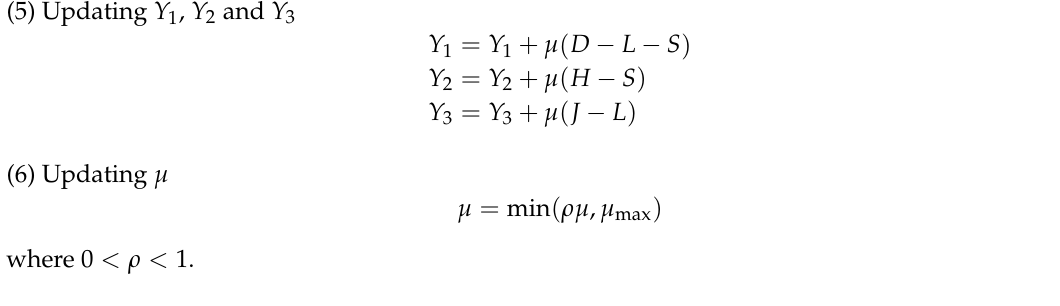
Algorithm 1 Solving DLRSD via